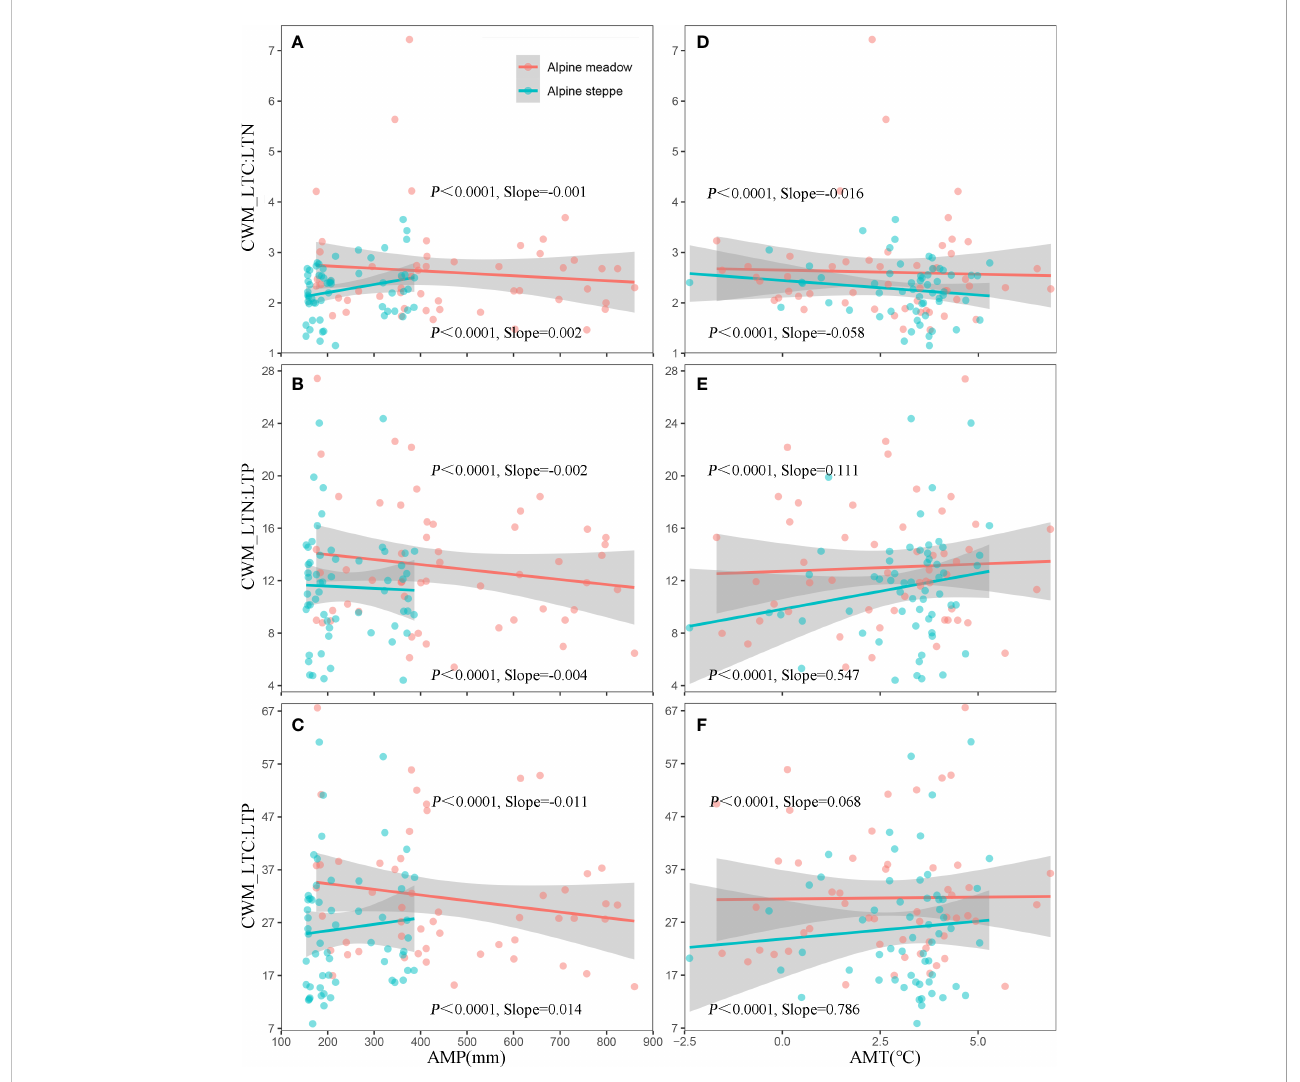
FIGURE 5 The linear fi ts of AMP to (A) CWM_LTC, (B) CWM_LTN, and (C) CWM_LTC and AMT to (D) CWM_LTC, (E) CWM_LTN, and (F) CWM_LTP. CWM_LTC, CWM_LTN, and CWM_LTP represent community-weighted mean of leaf total carbon, community-weighted mean of leaf total nitrogen, and community-weighted mean of leaf total phosphorus,